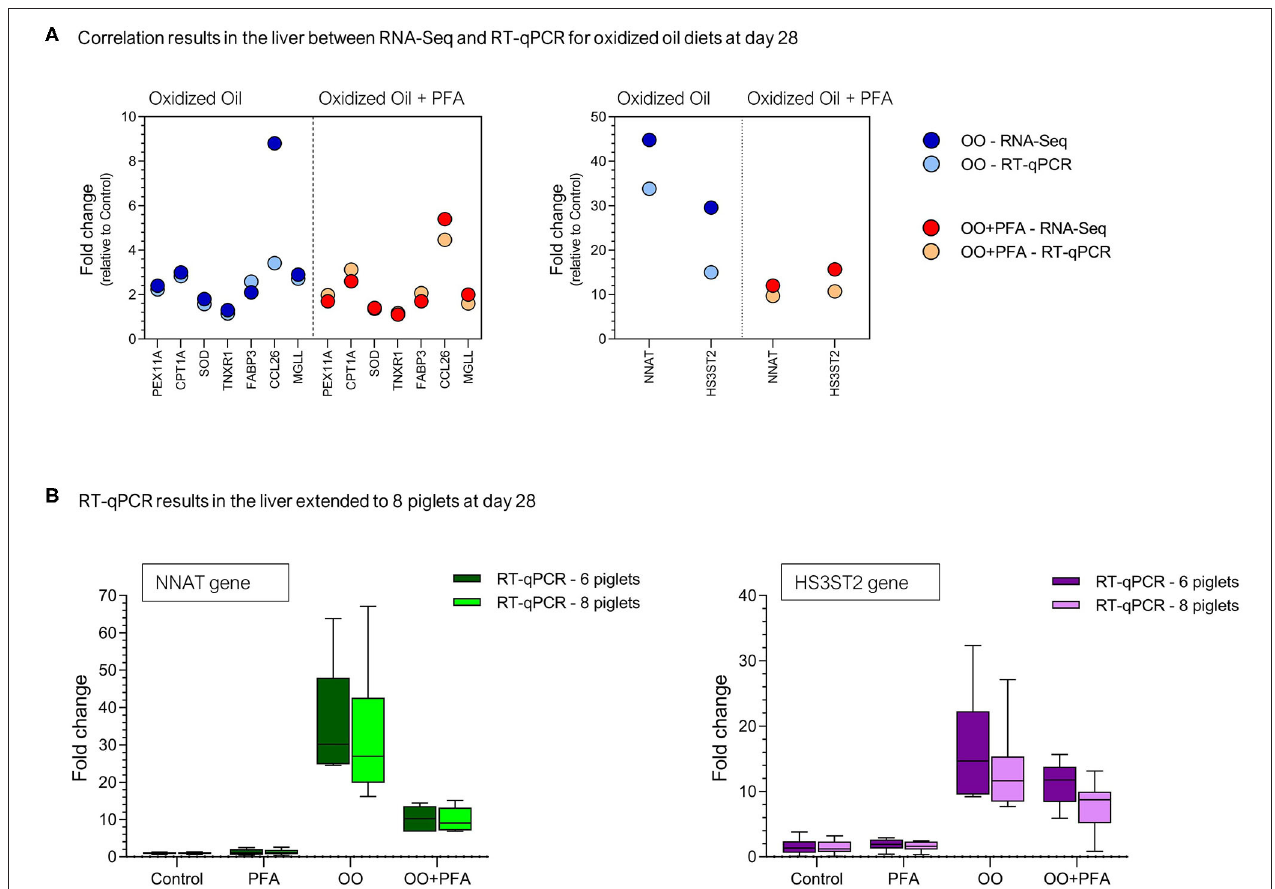
FIGURE 4 | RT-qPCR validation on selected genes at day 28. (A) Correlation between the fold changes observed in RNA-Seq and RT-qPCR for the same piglets ( n = 6). (B) Expression of the genes NNAT (Neuronatin) and HS3ST2 (Heparan sulfate glucosamine 3-O-sulfotransferase 2) via RT-qPCR in the liver of eight piglets (eight sampled initially but six used for RNA-Seq). PFA, Phytogenic Feed Additive; OO, Oxidized Oil; OO + PFA, Oxidized Oil + Phytogenic Feed